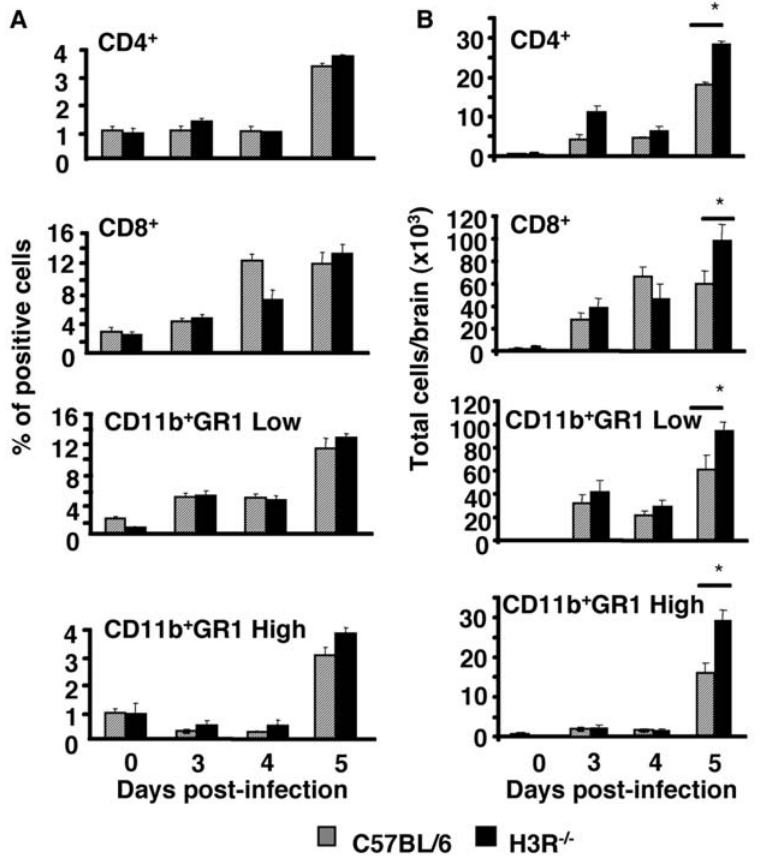
Figure 4. Characterization of brain infiltrating cells during infection with Pb ANKA parasites. At indicated time points post-infection, brains from C57BL/6 and H3R 2 / 2 mice infected with 10 6 infected erythrocytes per mouse of Pb ANKA strain were taken and leukocytes associated with cerebral tissue were analyzed for the presence of CD4 + and CD8 + T cells and other inflammatory cells. Data are expressed as a percentage of total cell population (A) and absolute cell numbers per brain (B). Six mice per group were used. Values represent the mean 6 standard deviation of two experiments. (B) Differences between C57BL/6 and H3R 2 / 2 mice are significant at day 5 for total CD4 + and CD8 + T cells (Mann-Whitney test, *p=0.04). Differences in total neutrophils/inflammatory monocytes (CD11b + GR1 High cells) and (CD11b + GR1 Low cells) between C57BL/6 and H3R 2 / 2 mice are significant at day 5 (Mann-Whitney test, *p=0.04, and p=0.046, respectively).